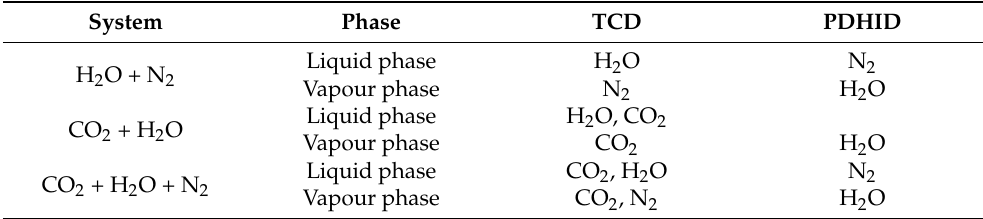
Table 4. For binary and ternary systems, the component that passed through the detector: thermal conductivity detector (TCD) or pulse-discharge helium ionisation detector (PDHID) (D-3-I-HP, Vici) in an Agilent 7890A GC with an HP-PLOT-Q capillary